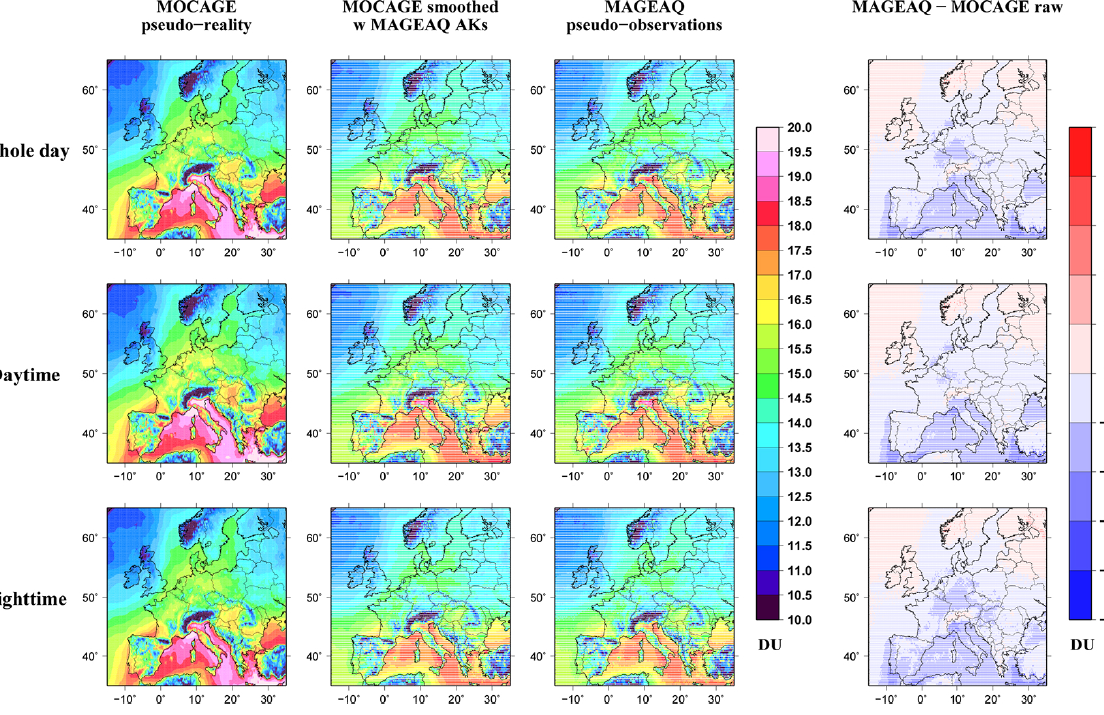
Fig. 5. Same as Fig. 4 but for surface–3km